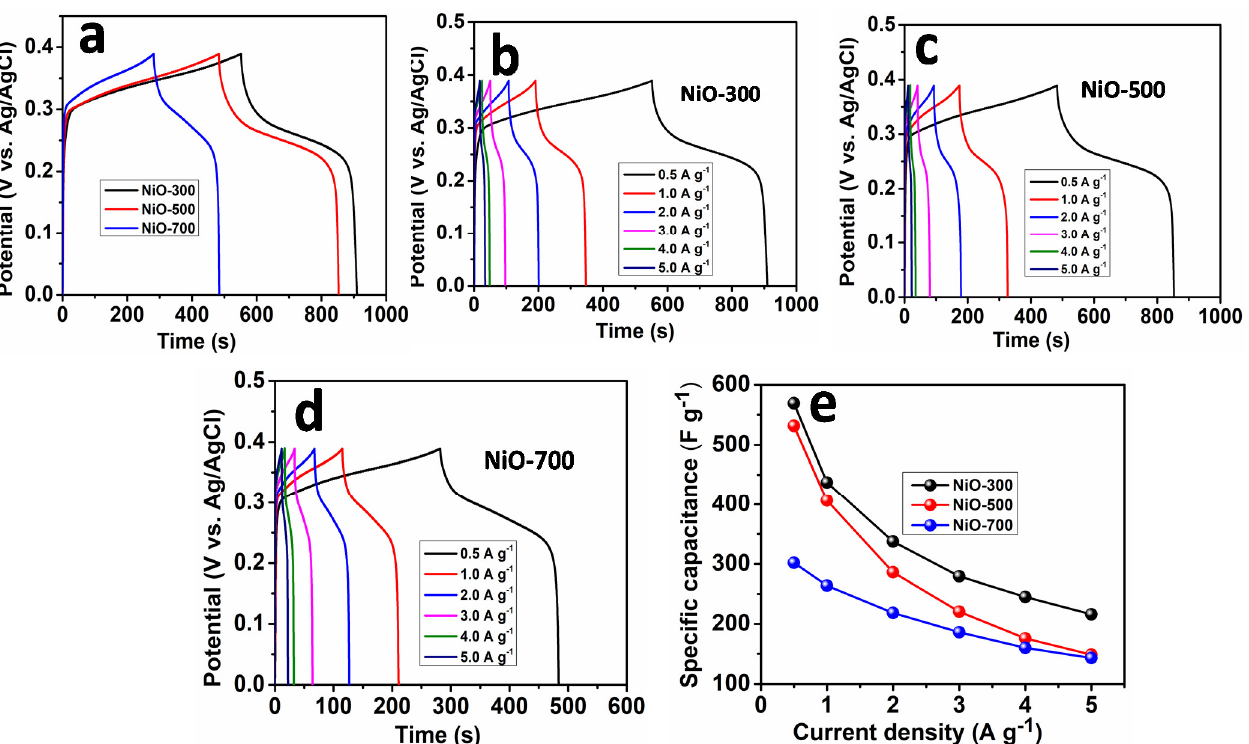
Figure 6. ( a ) Comparative GCD profiles of three different NiO electrodes; ( b – d ) GCD profiles of NiO-300, NiO-500, and NiO-700 at various densities of current; and ( e ) specific capacitances versus various current densities of NiO electrode materials.